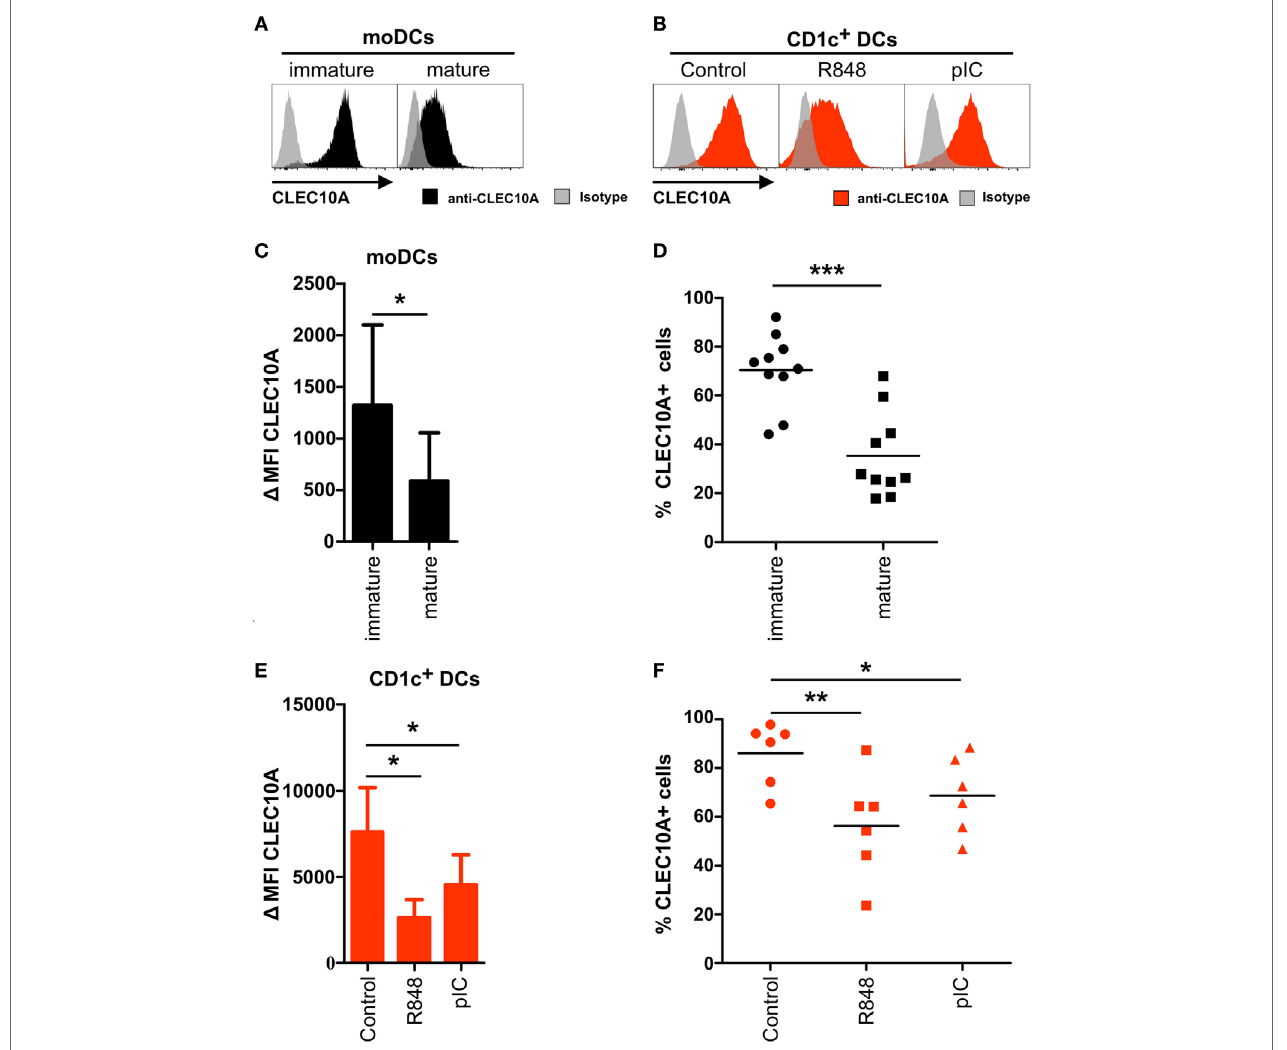
FigUre 4 | CLEC10A is downregulated on activated human CD1c + dendritic cells (DCs). (a,c,e) Monocyte-derived DCs were generated from blood monocytes of a healthy donor. After 6 days, half of the cells were matured using a maturation cocktail consisting of IL-1 β , IL-6, TNF α , and PGE 2 for 24 h. (B,D,F) Blood CD1c + DCs (red) were sorted from PBMCs of a healthy donor and subsequently stimulated either with R848 (5 µg/ml), pIC (5 µg/ml), or cultured in DC medium for 12 h at 37°C. Afterward, the cells were stained with an APC-labeled anti-CLEC10A antibody or an appropriate isotype control and analyzed using a BD LSRFortessa and FlowJo software. (a,B) Overlay histograms demonstrate a representative donor for (a) moDCs (black: CLEC10A; gray-transparent: isotype control) and (B) CD1c + DCs (red: CLEC10A; gray-transparent: isotype control). (c,e) Bar graphs show the expression of CLEC10A [mean ± SD of Δ MFI (MFI CLEC10A − MFI Isotype control )] on (c) moDCs ( n = 10) and (e) CD1c + DCs ( n = 6). (D,F) CLEC10A + (D) moDCs (black symbols) and (F) CD1c + DCs (red symbols) were determined using an appropriate isotype control and blotted as scatter plots. Significant differences in the (c,e) expression of CLEC10A or (D,F) percentages of CLEC10A + cells were